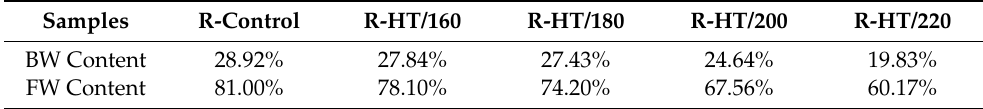
Figure 5. The dynamic change in BW ( a , c ) amount and FW amount ( b , d ) for the wood samples during 60 days of water absorption. Table 3. The content of BW and FW of the wood samples after 60 days of water absorption in the R direction.